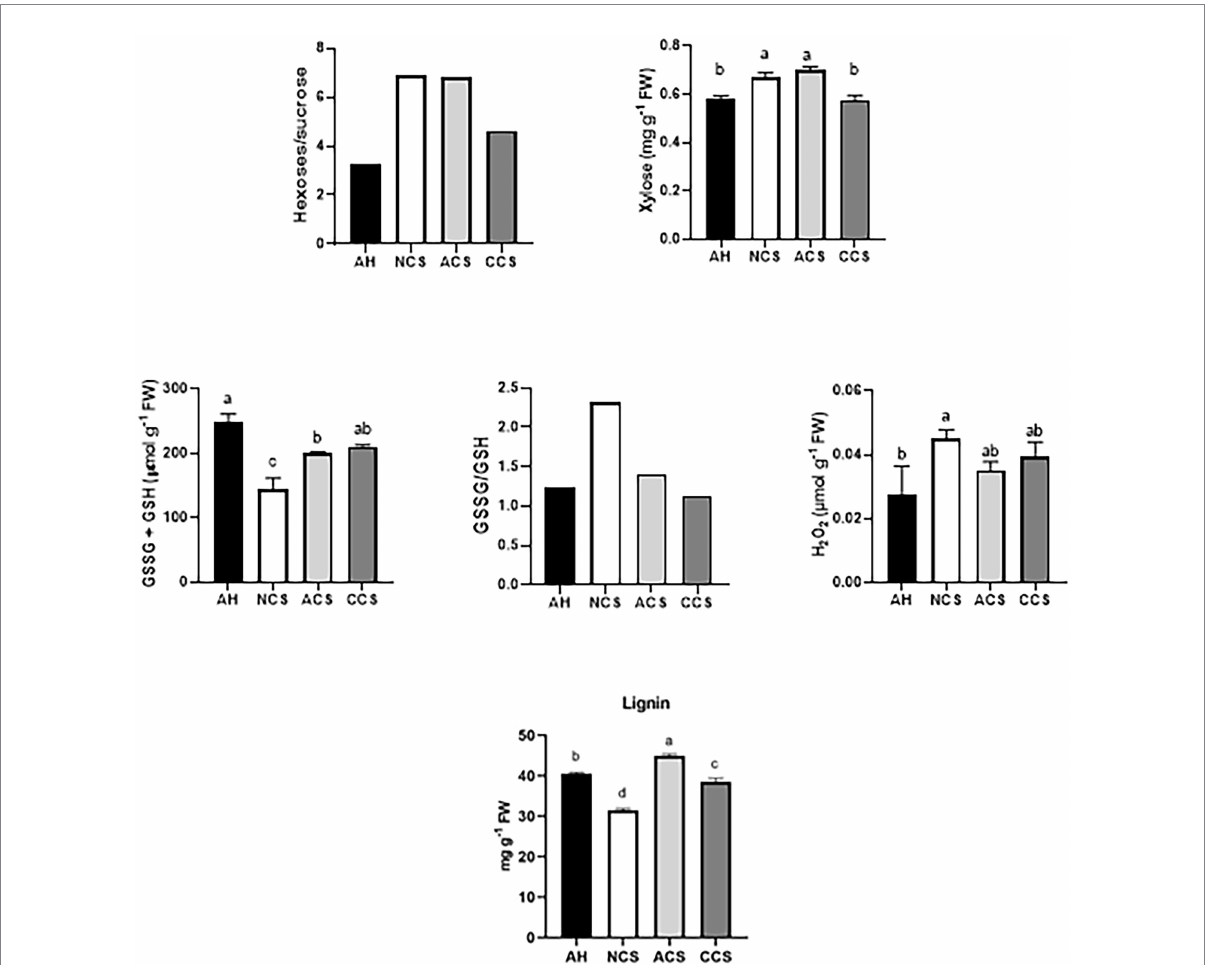
FIGURE 1 Strawberries with contrasting cold storage conditions exhibiting different senescence-like responses and oxidative stress markers including: ratio of hexoses/sucrose, content of xylose, H 2 O 2 and glutathione (GSH + GSSG reduced plus oxidized glutathione forms), ratio of GSSG/GSH and lignin content. Strawberries immediately after harvest were used as the control sample (AH). Those placed directly in a chamber at 20 ° C were used as non-cold stored samples (NCS), while the strawberries transferred at 20 ° C following cold-stored fruit (ACS) or CO 2 -cold stored fruit (CCS). Graphs represent the average of at least three independent replicates (each one contains 15 fruits). Mean values ( n = 3 ± standard deviation). (a-c) For each parameter, mean values with different letters are significantly different ( p < 0.05) according to the Tukey’s multiple range